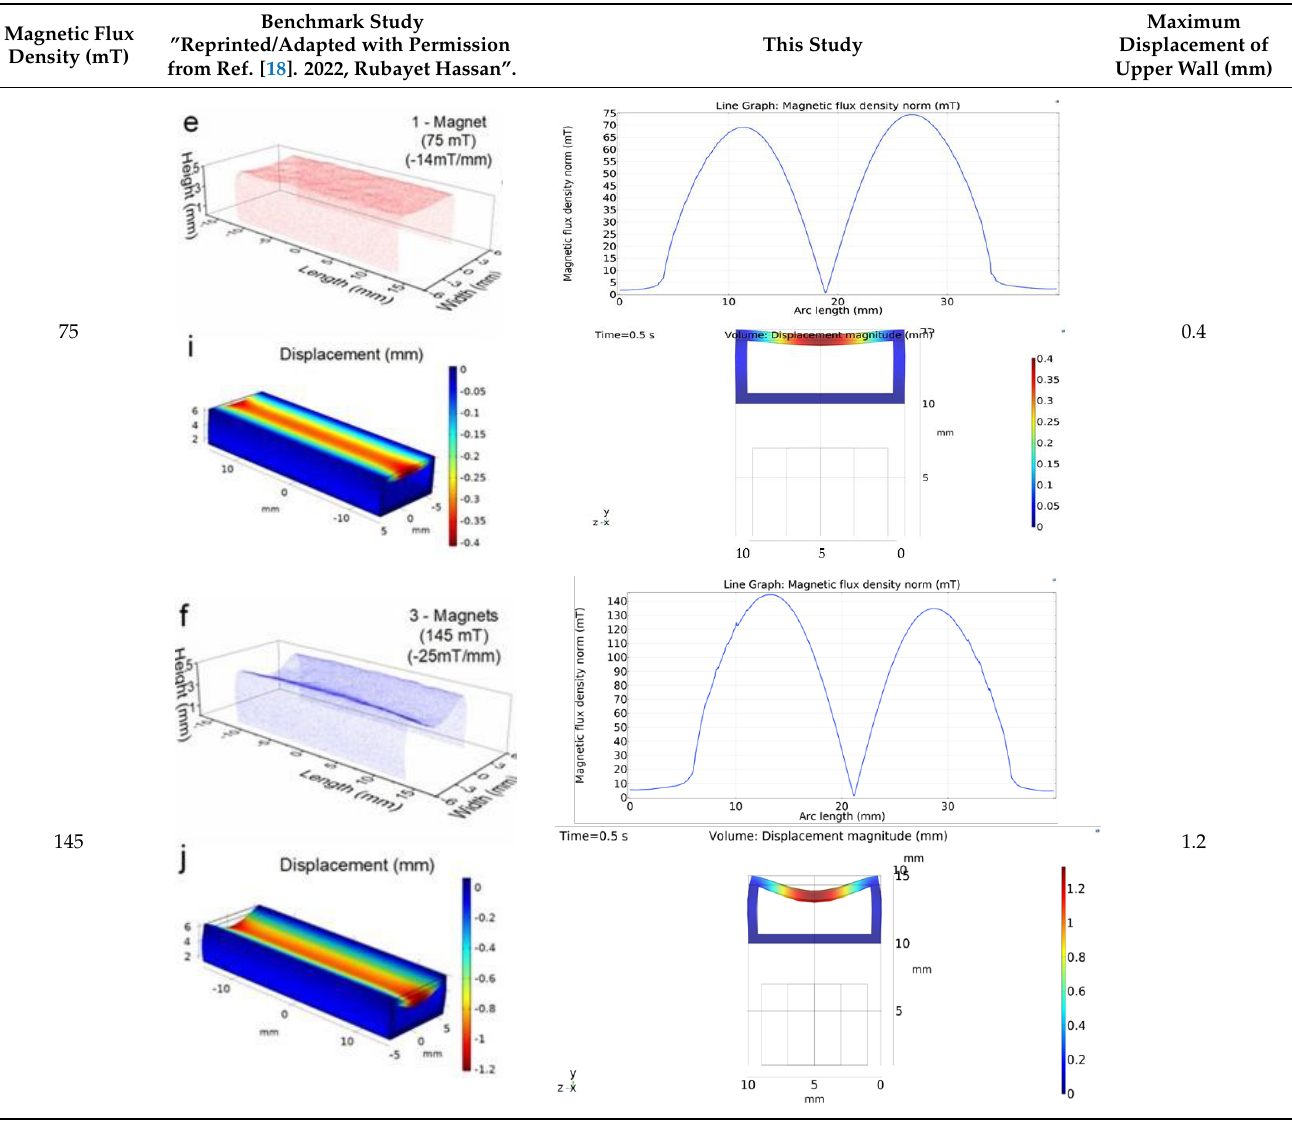
Figure 7. Schematic of the model studied in “Reprinted/adapted with permission from Ref. [18]. 2022, Rubayet Hassan” : ( a ) 3D view; ( b ) front view; and ( c ) side view.